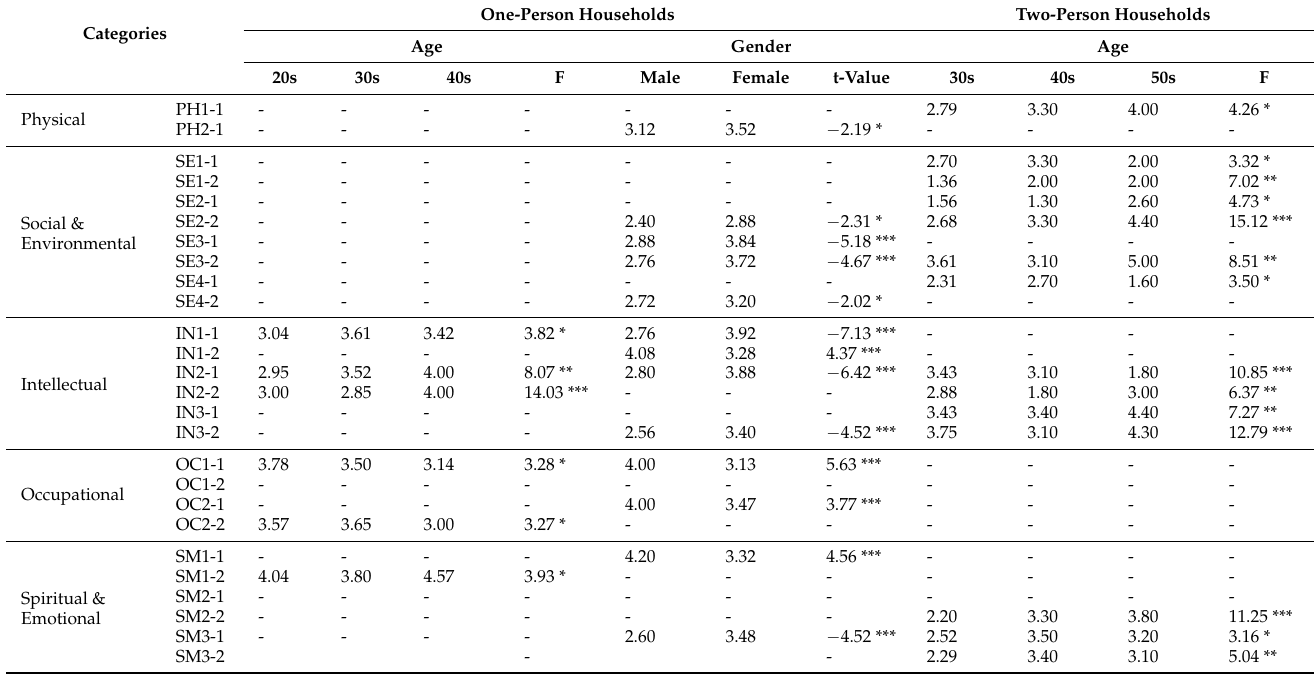
Table 7. Wellness of One-person and Two-person Households According to Demographic Character- istics (only statistically significant items are